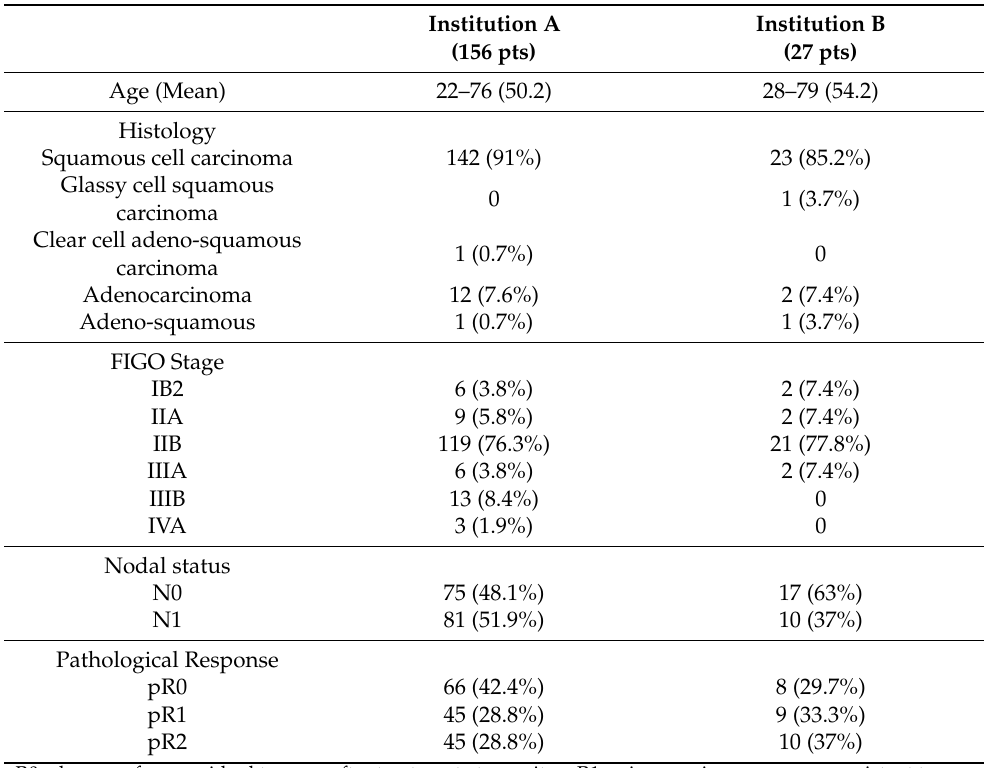
Table 1. Patient